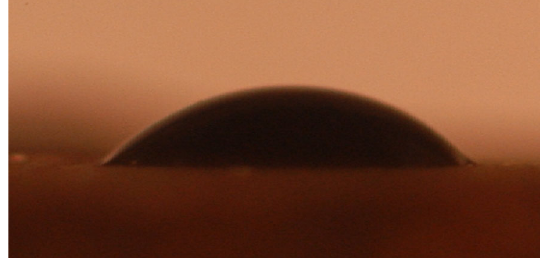
Fig. 10 Oil droplet on sandstone